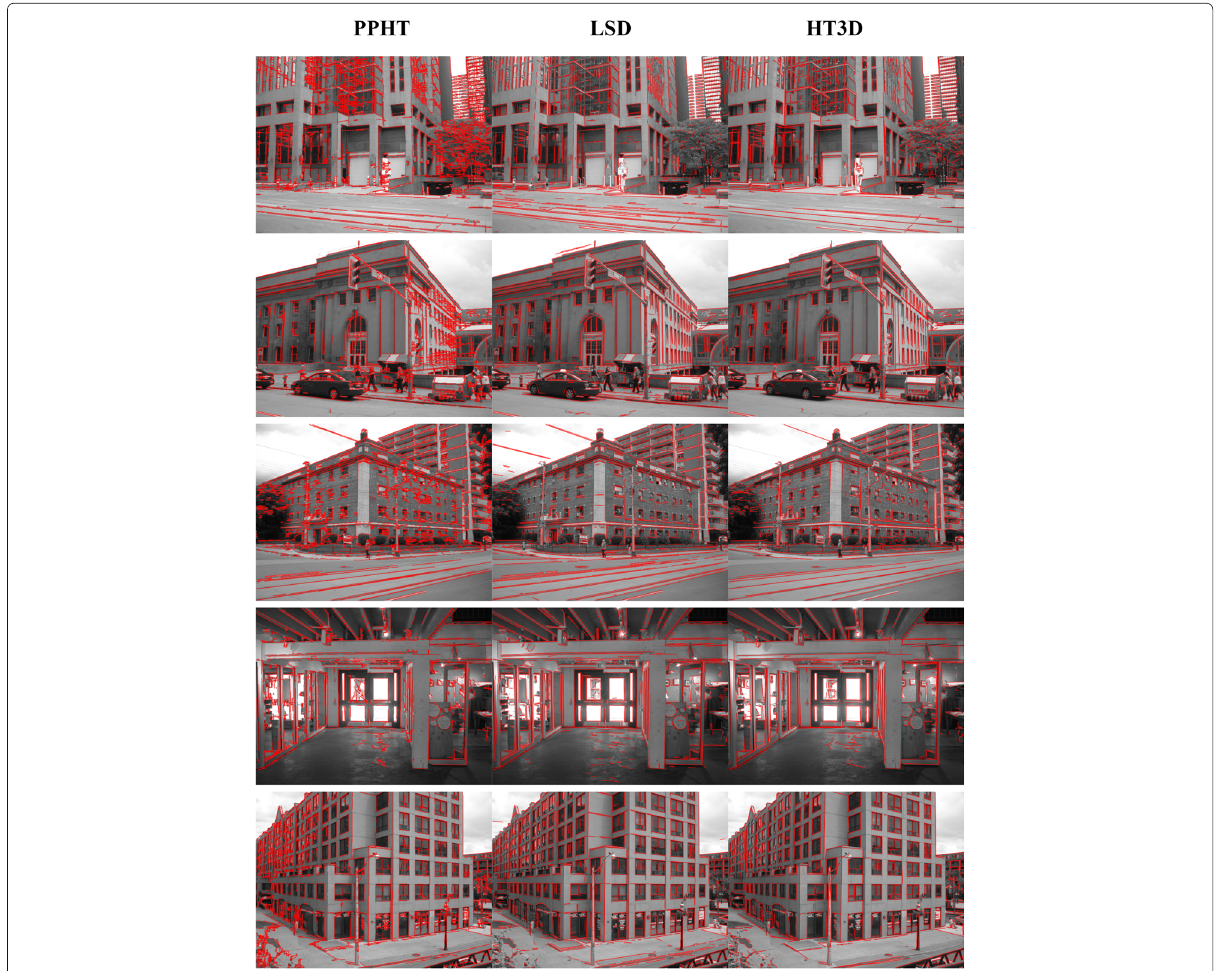
Fig. 21 Detected segments for the second set of